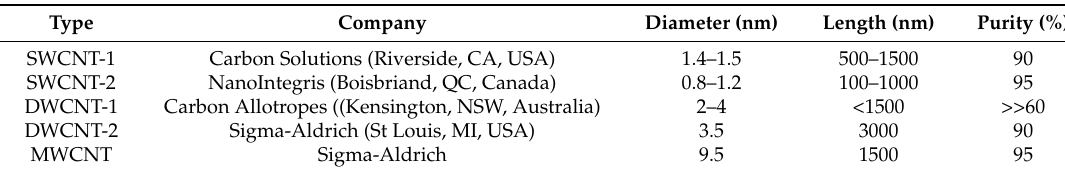
Table 5. Types of nanotube samples